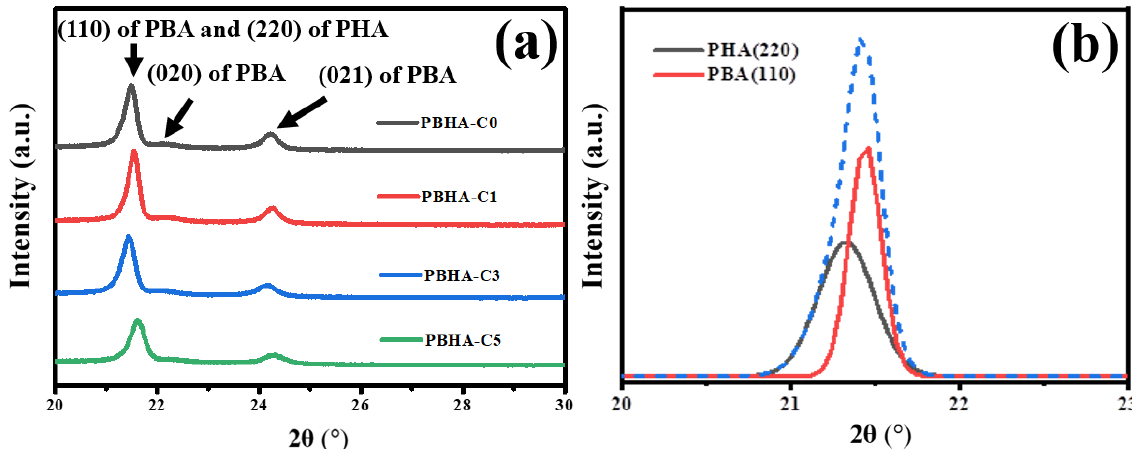
Figure 6. ( a ) XRD patterns of PBHA-Cn copolymers, and ( b ) the overlap feature peak by (110) of PBA and (220) of PHA.